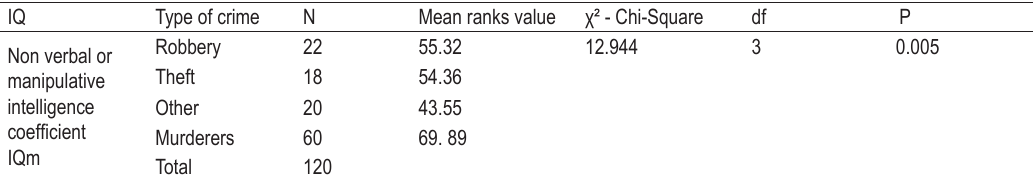
TABLE 6. Testing the IQm signi fi cance of difference between all groups and sub-groups of inmates using factorial analysis of variance ranks (Kruskal-Wallis test)